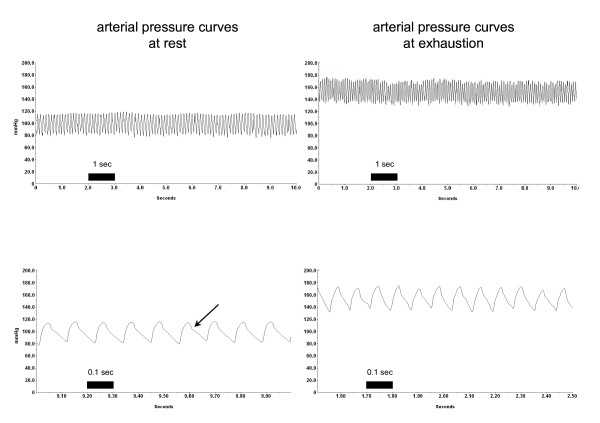
Representative examples of original data of blood pressure measurements at rest and during maximal exercise (exhaustion) on the treadmill. The upper row shows 10-second intervals, the lower row represents 1-second intervals cut from the above sample. Typical arterial blood pressure waveforms with a visible dichrotic notch (arrow) were obtained from the same tg6 mouse, with almost no artefacts. At rest, mean values (calculated from 10-second intervals) were as follows: systolic blood pressure 115 [standard deviation (SD) 3.0] mmHg; diastolic blood pressure 86 (SD 2.4) mmHg; heart rate 555 (SD 2.4) beats per minute. At exhaustion, mean values (calculated from 10-second intervals) were: systolic blood pressure 170 (SD 0.9) mmHg; diastolic blood pressure 135 (SD 0.7) mmHg; heart rate 750 (SD 0.01) beats per minute.